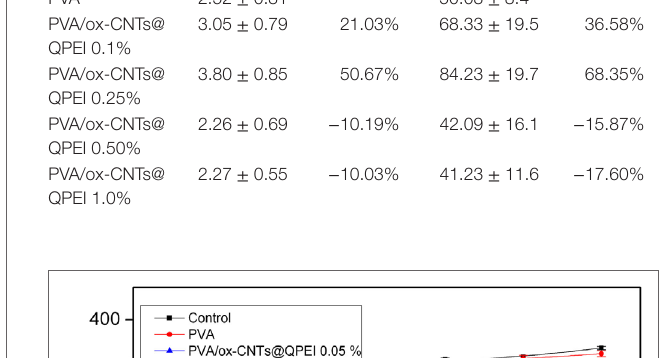
FigUre 10 | Thermogravimetric profiles of poly(vinyl alcohol) (PVA) and PVA/ ox­CNTs@QPEI nanocomposite